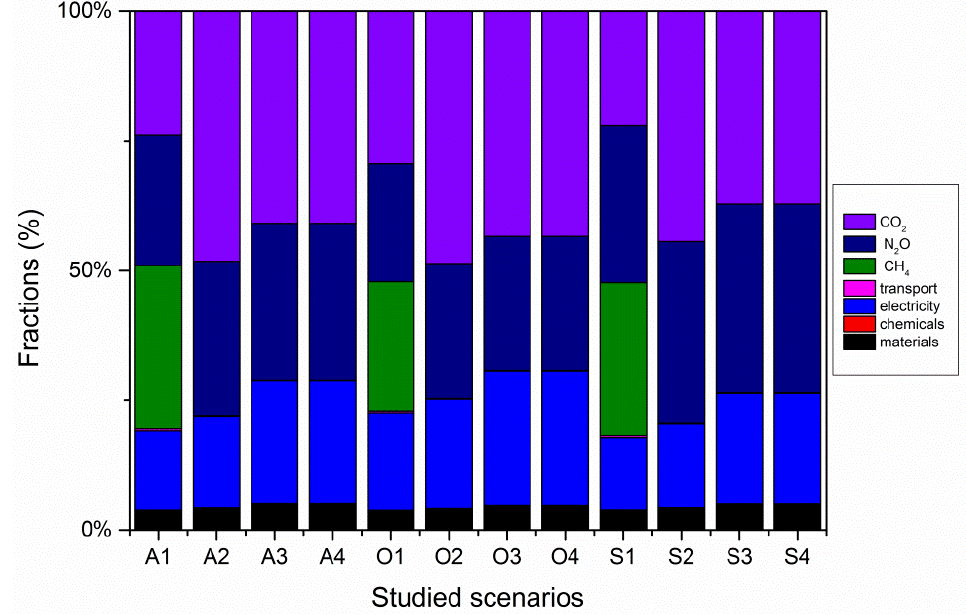
Figure 3. Proportions of different sources for GHG emissions of wastewater and sludge